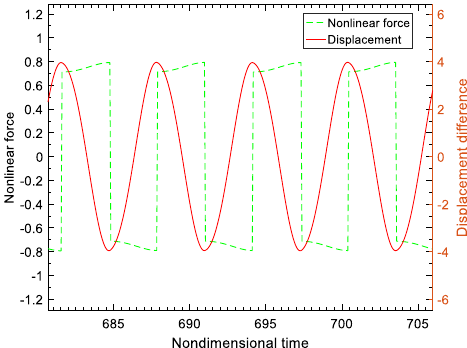
Figure 9. Displacement difference and nonlinear force.